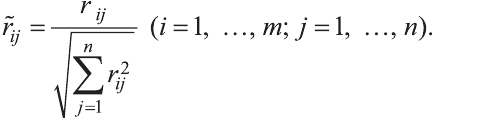
Table 1 . The data on the alternatives of the considered object Criteria Criteria